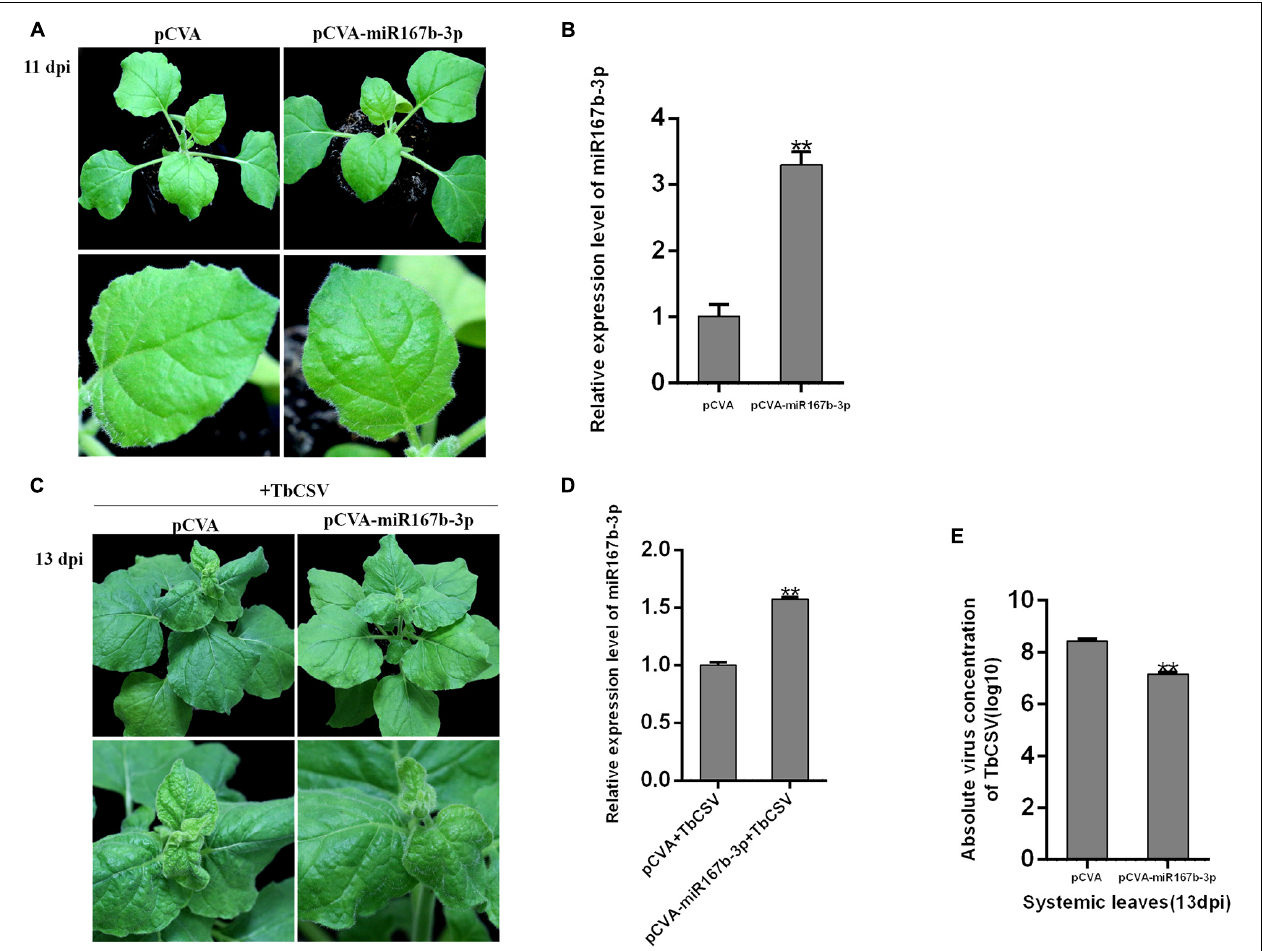
FIGURE 4 | Overexpression of nbe-miR167b-3p attenuated leaf curling symptom induced by TbCSV and reduced viral DNA accumulation. (A) pCVA-based miRNA vector (pCVA-miR167b-3p) was used to increase expression of nbe-miR167b-3p. (B) Result of qRT-PCR showed that expression of nbe-miR167b-3p in the pCVA-miR167b-3p-inoculated plants was significantly increased compared with that of the control plants (pCVA). (C) TbCSV was inoculated onto pCVA-miR167b-3p -treated and control plants. (D) qRT-PCR showed that the level of nbe-miR167b-3p in TbCSV-infected and pCVA-miR167b-3p-treated plants was significantly increased compared with that of the TbCSV-infected pCVA-treated plants. (E) TbCSV DNA copy numbers in the systemic leaves harvested from the pCVA plus TbCSV-inoculated plants or the pCVA-miR167b-3p plus TbCSV-inoculated plants. Significance of difference between treatments (* p < 0.05; ** p < 0.01) was determined by the Student’s t